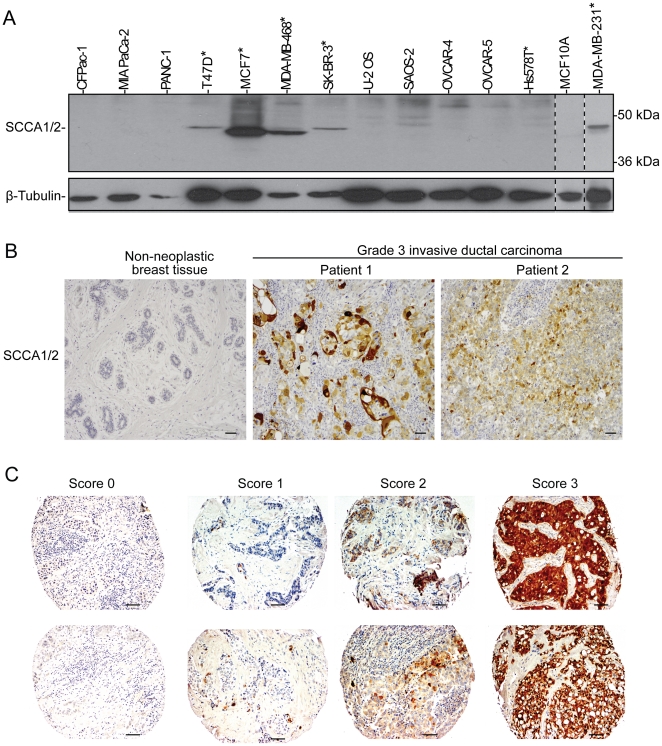
Elevated SCCA expression is found in human breast cancer cell lines and human breast cancer carcinomas, but not in normal breast epithelium.(A) A panel of human cancer cells was probed for SCCA expression by immunoblotting. Five out of the six breast cancer cell lines (denoted with an asterisk) were positive for SCCA expression. (B) IHC analysis was performed on an array of breast carcinomas and normal breast tissue obtained from CHTN, using antibody FL-390. Representative images of normal breast tissue and sections with Grade III invasive ductal carcinoma are shown. (C) IHC staining was performed on the NCI CDP breast cancer progression and the prognostic TMAs using antibody FL-390. SCCA staining was scored on a tiered-scale (0–3). A representative panel is shown. Scale bars  = 50 µm.